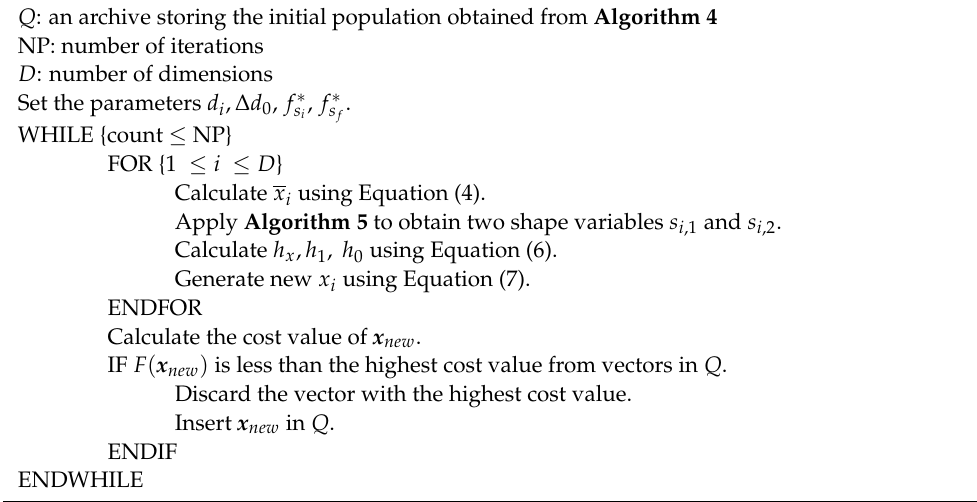
Algorithm 6 Generating n -best offspring using